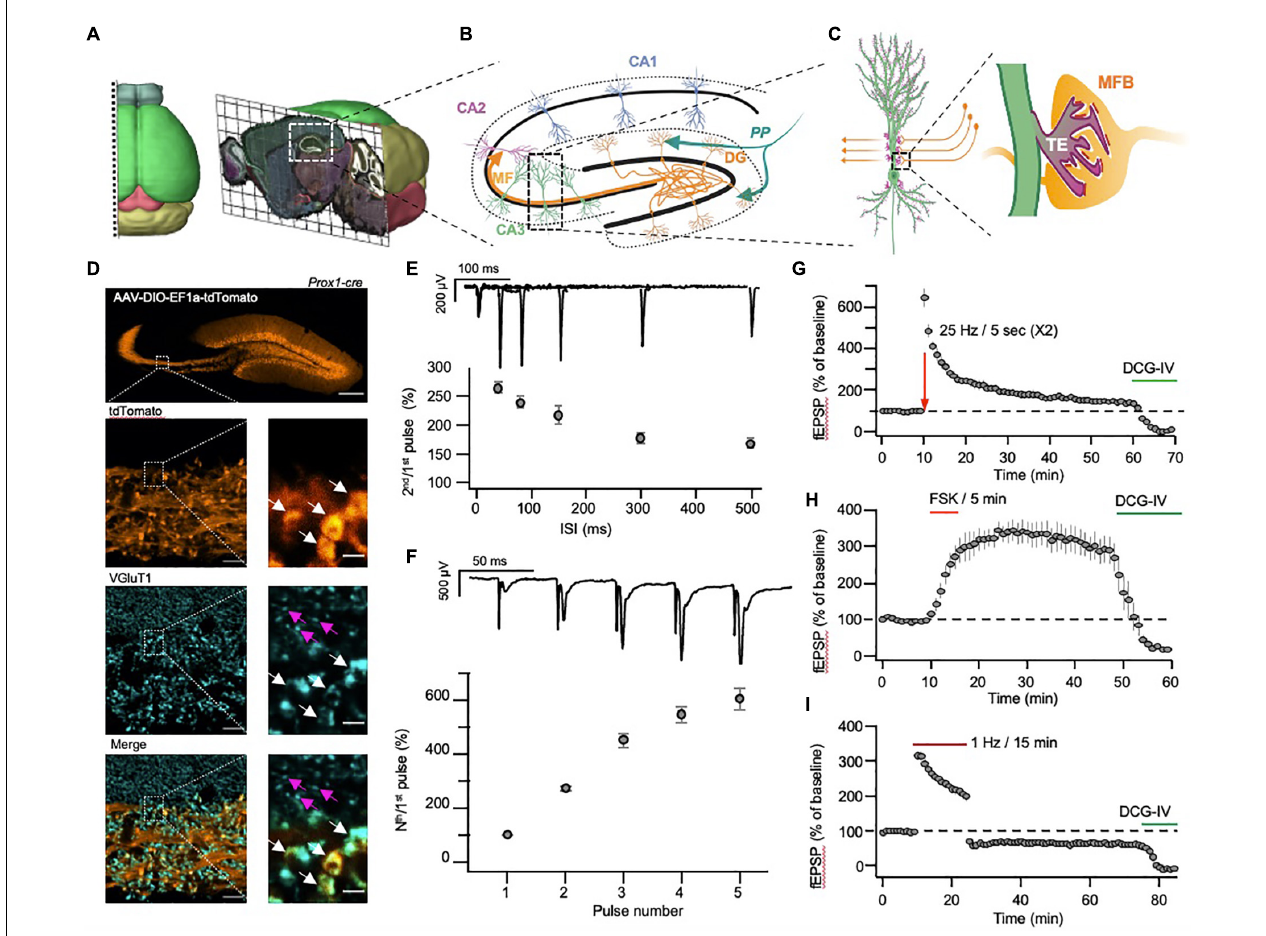
FIGURE 1 | Morphological and physiological properties of the hippocampal mossy fiber pathway. (A) Three-dimensional visualization of the anatomical location of the dorsal hippocampus in mouse brain. (B) Schematic representation of hippocampal sub-regions, with emphasis on the input and output to and from the DG. (C) Schematic representation of the unique anatomical and morphological structure of the MF-CA3 synapse. Insert: mossy fiber bouton (MFB, orange) and postsynaptic thorny excrescence (TE, light green). (D) A representative confocal image of the hippocampus following injection of AAV-DIO-EF1a-tdTomato into the DG of a Prox1-cre transgenic mouse (top). The images below show the MF tract at higher magnification (tdTomato, orange), following immunolabeling for VGluT1 (VGluT1, cyan), and demonstrate the size differences between the large MF terminals (white arrows) and the small S.R. terminals (magenta arrows). Scale bars represent 200, 10 and 2 µ m for the top, right column and left column images, respectively. (E,F) MF-CA3 short-term plasticity demonstrated by measurements of paired-pulse (E) and a high-frequency burst (F) stimulation, delivered electrically to the DG while recording fEPSPs from the S.L. (G,H) MF-CA3 long-term plasticity demonstrated by measurements of FSK- (G) and tetanus- (H) induced potentiation, with subsequent application of DCG-IV, blocking synaptic transmission. (I). MF-CA3 long-term plasticity (LTD) following a prolonged low-frequency stimulation, with subsequent application of DCG-IV, blocking synaptic transmission. Images in (A) were adapted from the Allen institute’s Brain Explorer 2